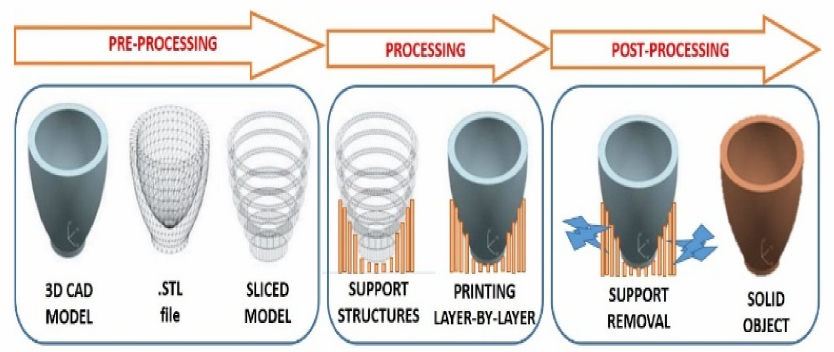
Figure 2. Schematic of AM process flow